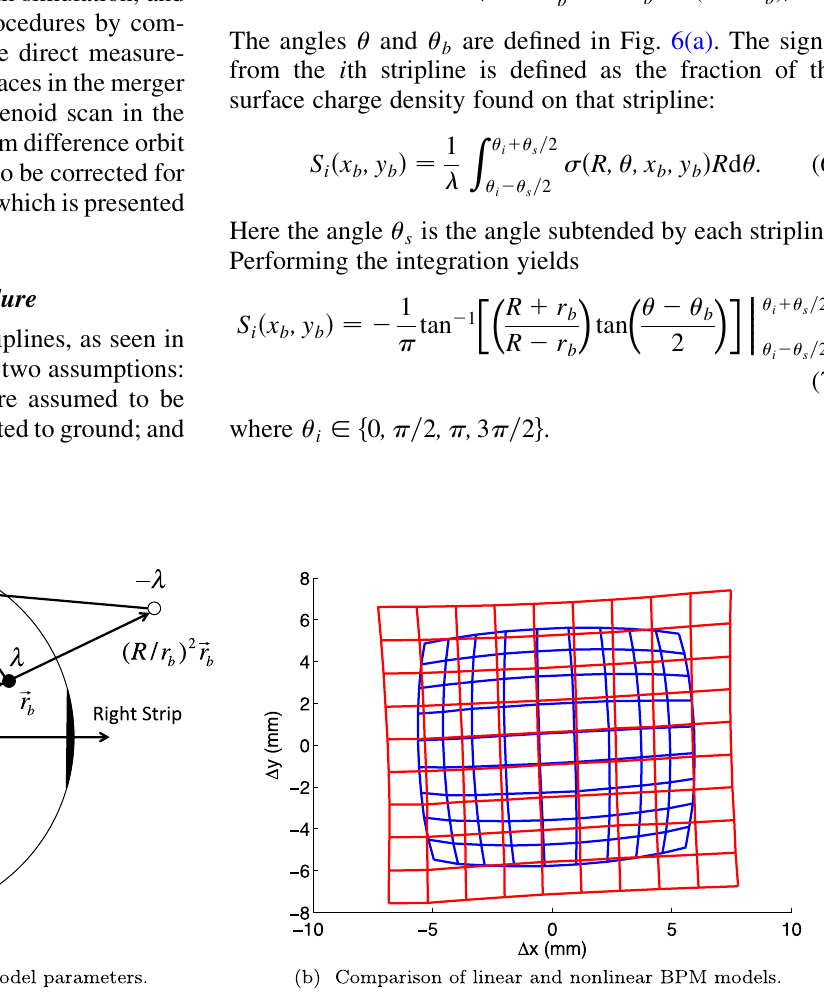
FIG. 6. Nonlinear BPM model description and verification: (a) shows the relevant parameters for the model, while (b) shows the comparison of the standard linear BPM position calculation (blue) and positions computed with a nonlinear correction (red) from a square grid scan of an upstream horizontal and vertical corrector